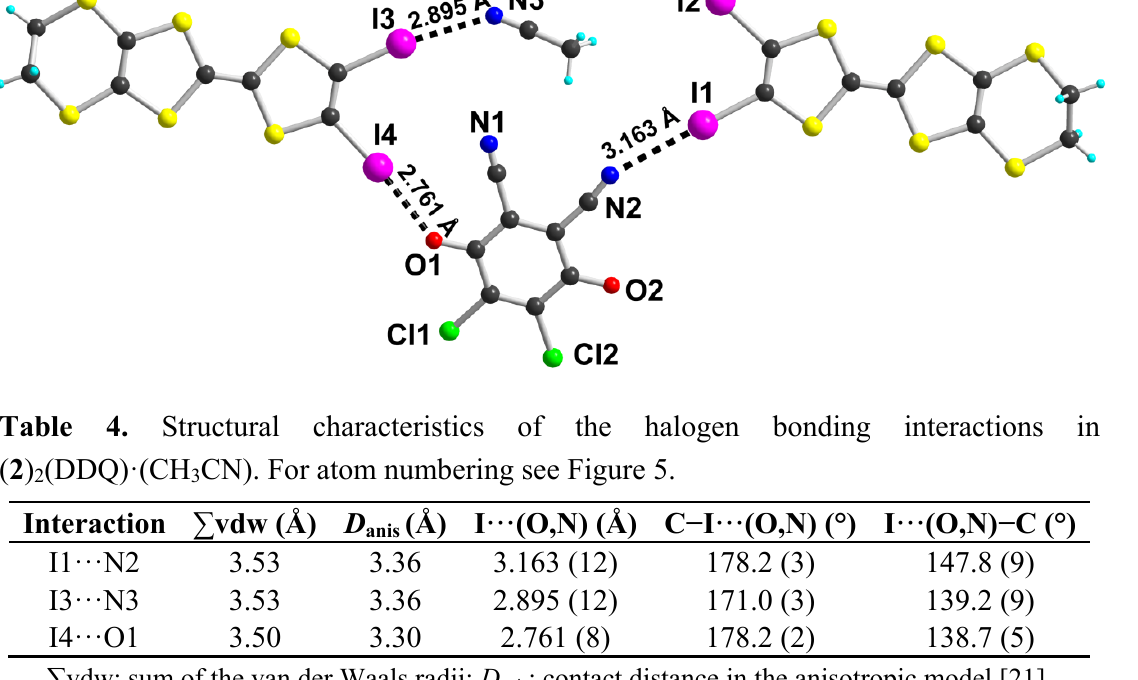
Figure 5 . Details of the halogen bonding interactions in ( 2 )